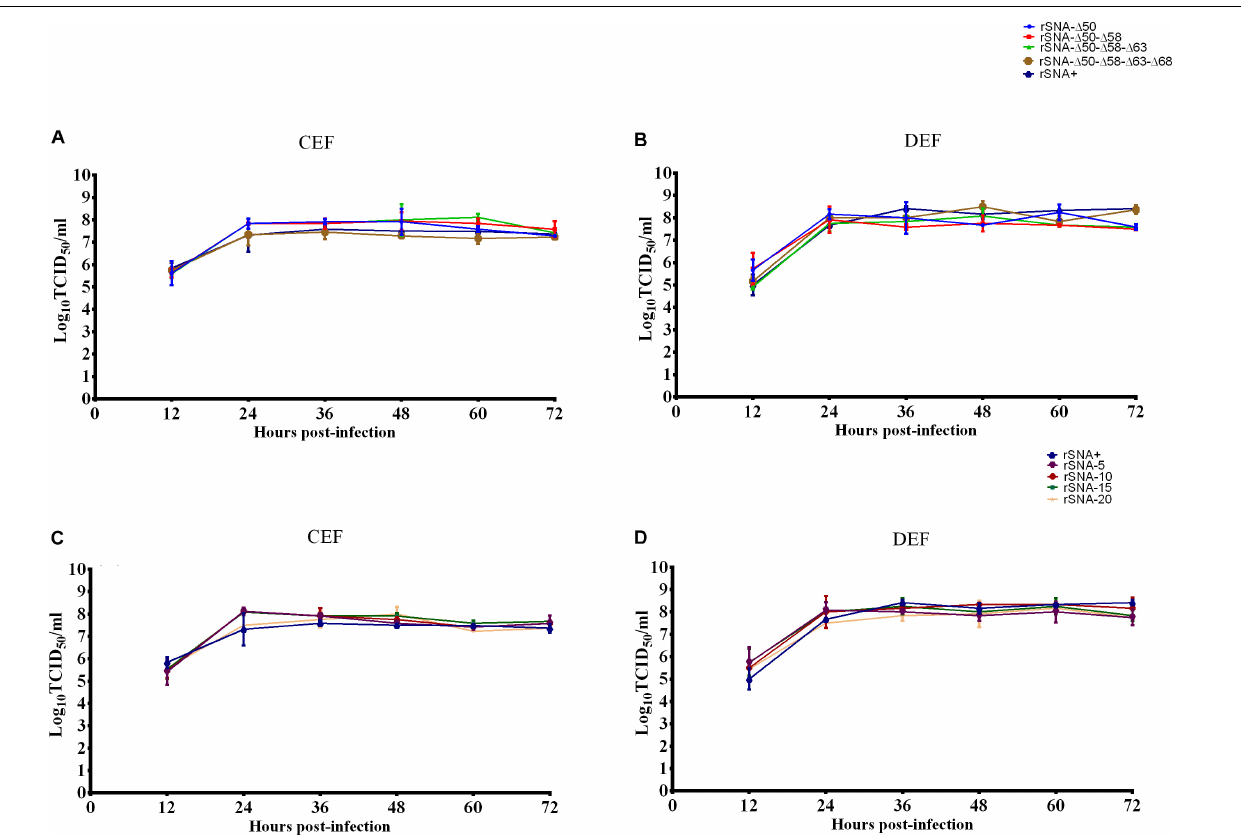
FIGURE 2 | Growth curves of recombinant viruses in CEF (A,C) and DEF (B,D) cells. The mean and standard errors are shown from three independent experiments.